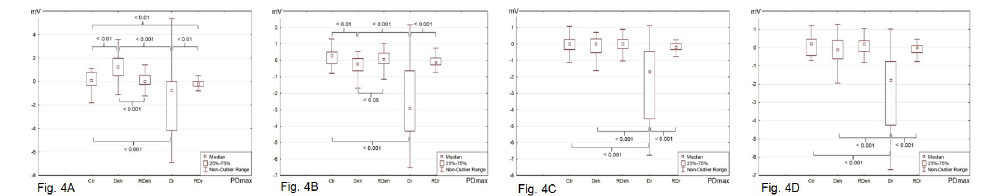
Fig 4. The maximal transepithelial electric potential (PDmax, mV) measured in 15s mechanical–chemical stimulation of the isolated rabbit skin specimens with the use of: (a) Ringer’s solution (RH); (b) bumetanide (0.1 mM) solution; (c) amiloride (0.1 mM) solution; (d) solution of amiloride (0.1 mM) and bumetanide (0.1 mM). The skin specimens were pre–treated as follows: Ctr (control: skin specimens incubated in RH for 30 min), Deh (dehydrated: skin specimens incubated in 10% NaCl for 30 min), RDeh (rehydrated after dehydration: skin specimens rehydrated in RH for 30 min after incubation in 10% NaCl for 30 min), Dr (dried: skin specimens dried at 37˚C for 60 min), RDr (rehydrated after drying: skin specimens rehydrated in RH for 60 min after drying at 37˚C for 60 min). The p values < 0.05 were considered as statistically significant.